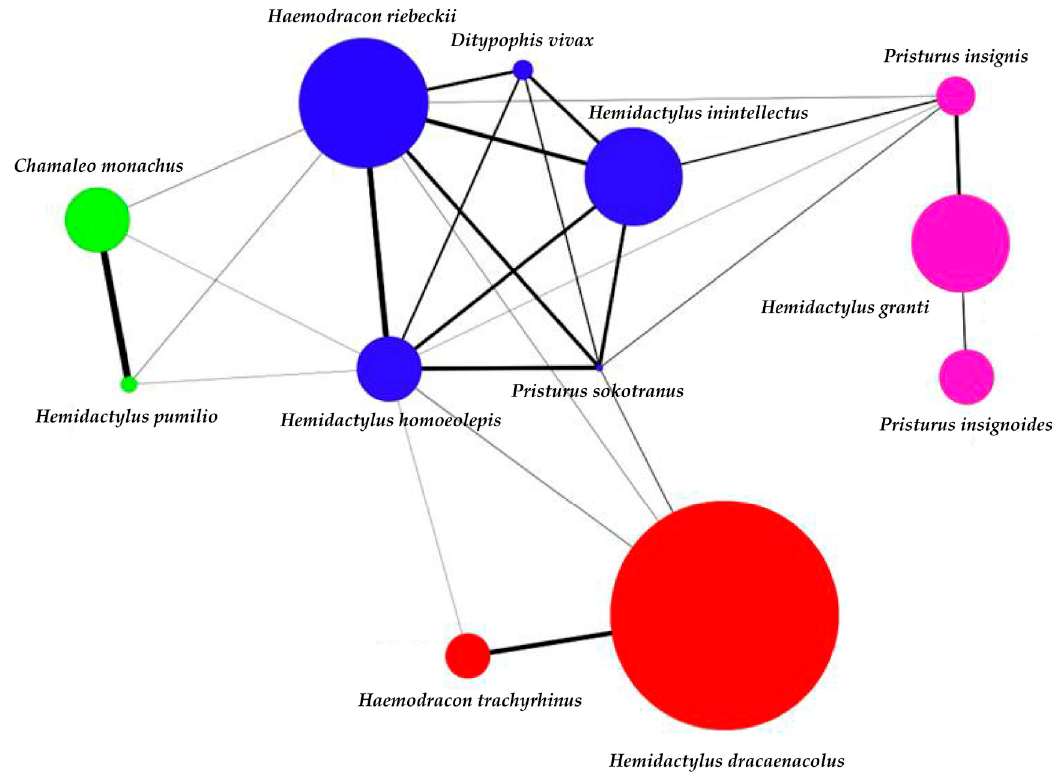
Figure 2. Ecological network of the Socotran reptiles found in Dracaena cinnabari Balf.f. trees. Nodes represent species; their size indicates the degree of specialization in the use of D. cinnabari trees with respect to other habitats, and colors indicate sub-communities according to the partition procedure (green: shrub / tree specialist community; blue: habitat generalists community; pink: rock-dwelling community; red: arboreal / shrub species). Edges join species that share at least one sampling point, and the higher thickness of the edges indicates those species with higher co-occurrence patterns within the 11 sampling